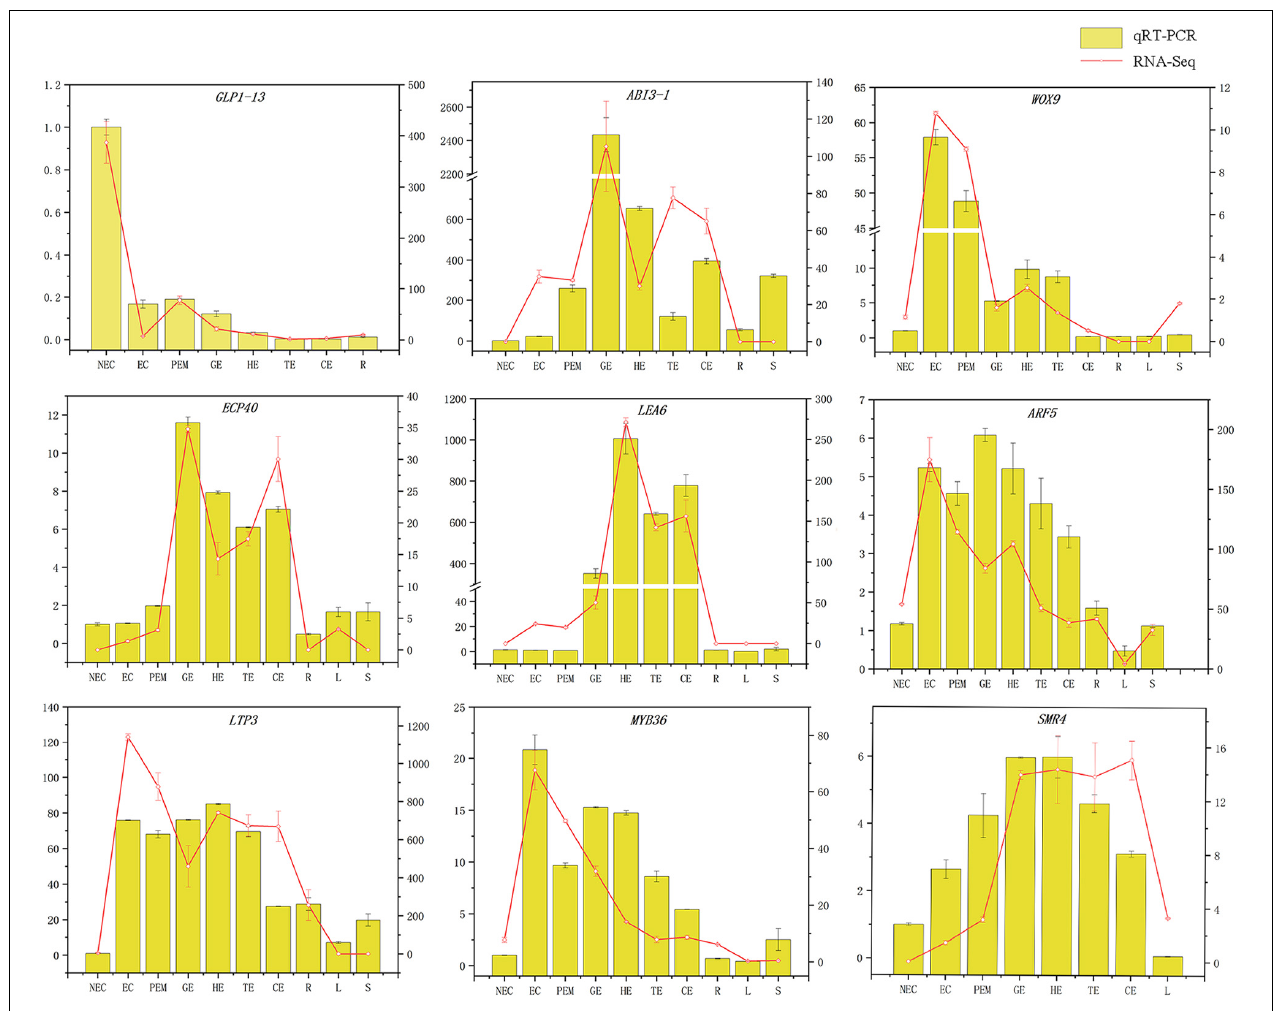
FIGURE 8 | Comparison of expression profiles of ten representative genes as measured by RNA-seq and qRT-PCR. Columns represent expression determined by qRT-PCR (left y-axis), while lines represent expression by RNA-seq in FPKM values (right y-axis). The x-axis in each chart represents the ten stages (NEC-S). For qRT-PCR assay, the mean was calculated from three biological replicates each with three technical replicates ( n = 9). For RNA-seq, each point is the mean of three biological